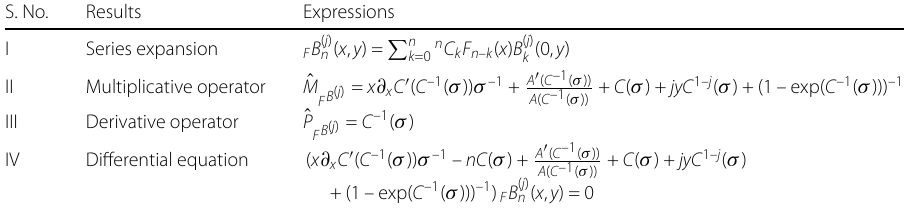
Table 7 Results for Boas–Buck–Bernoulli polynomials F B ( j ) n ( x , y ) S. No.